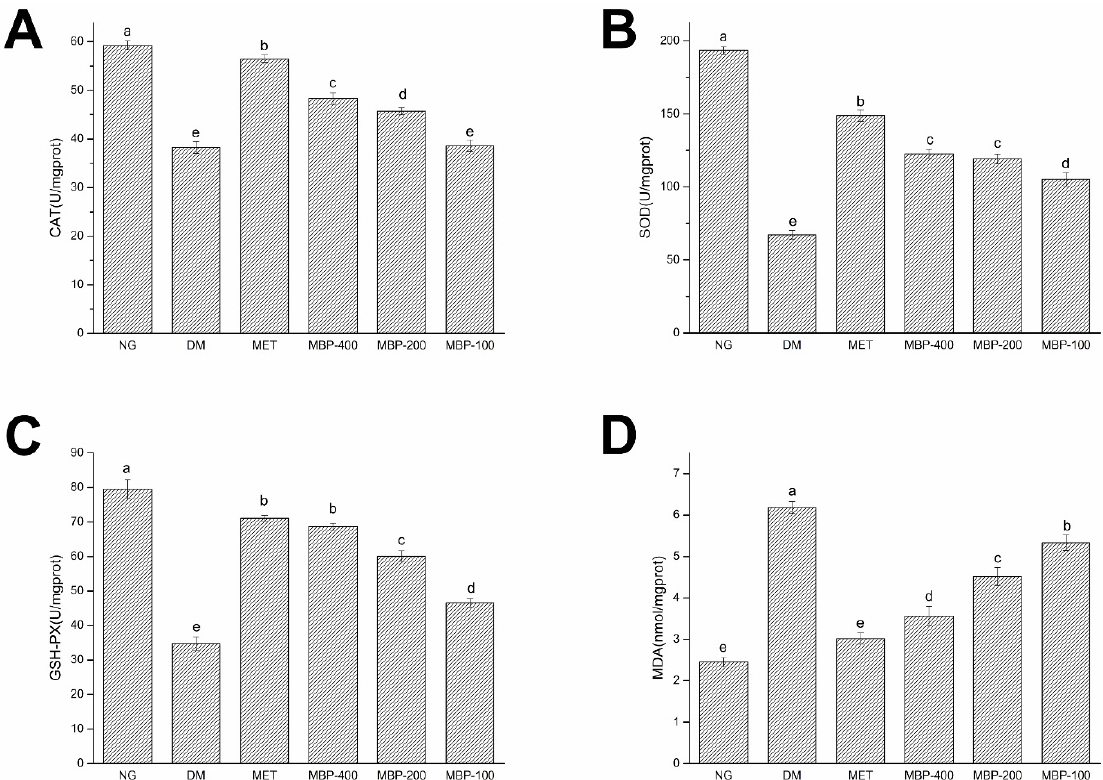
Figure 3. Expression of catalase(CAT) ( A ), superoxide dismutase (SOD) ( B ), glutathione peroxi- dase( GSH-Px) ( C ), and malondialdehyde (MDA) ( D ) in liver of rats. Different letters are signifi- cantly different at p < 0.05 .